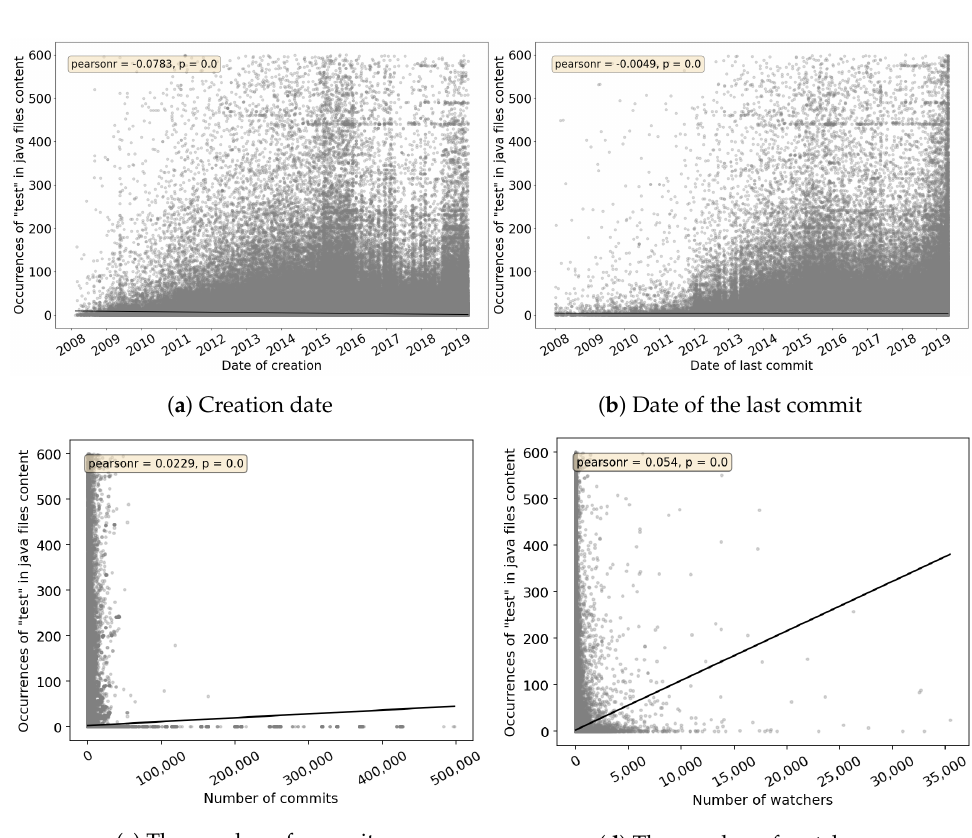
Figure 4. Correlation between the number of occurrences of the word “test” in all java files’ content and the project’s life cycle